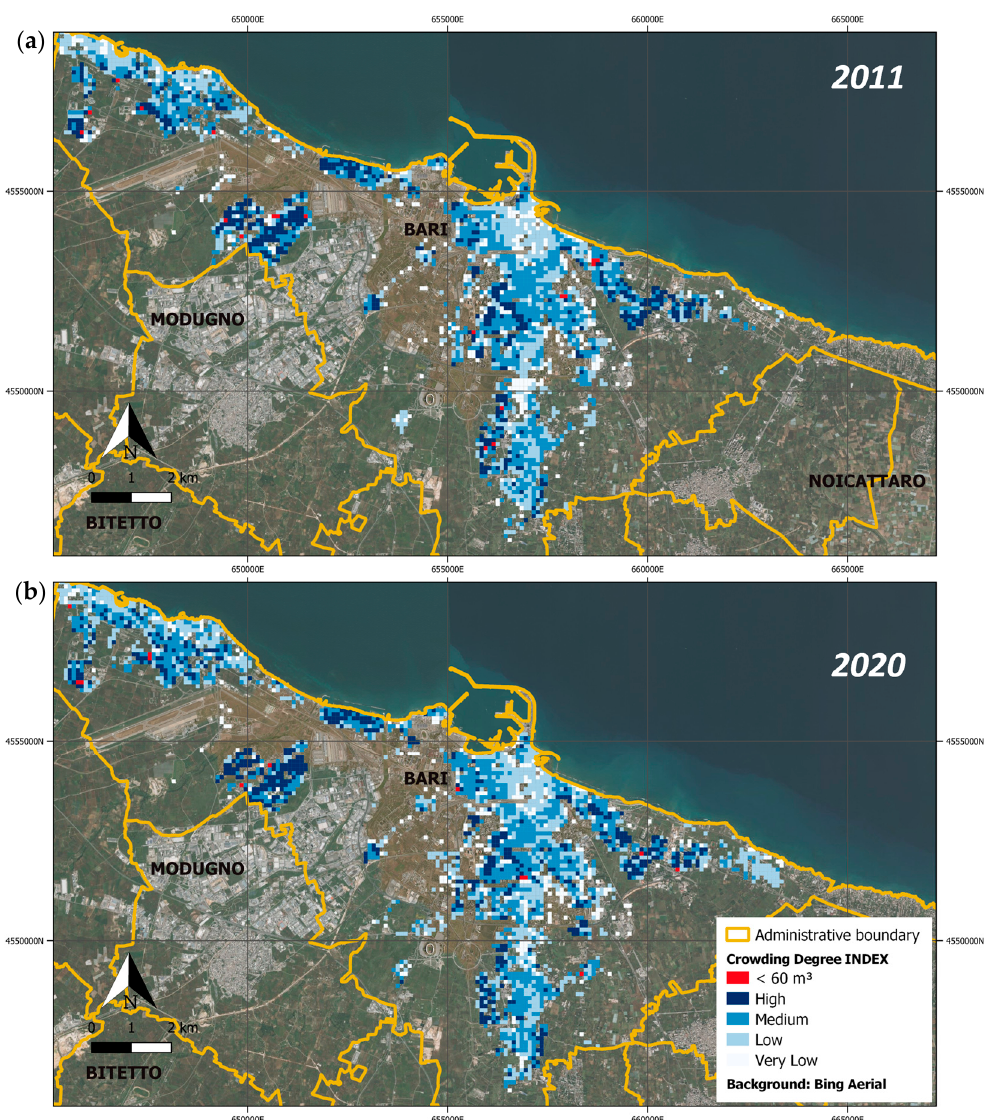
Figure 20. SDG 11.1.1 sub-indicator (3). The proportion of households with insufficient living space from crowding degree map in ( a ) 2011, and ( b ) 2020.